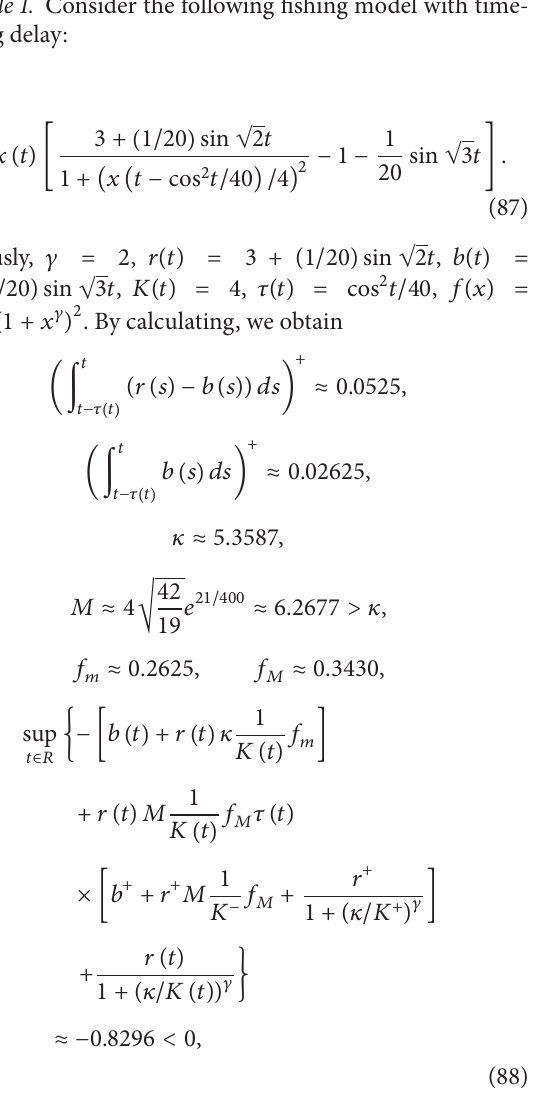
which imply that (87) satisfies the assumptions of Theorem